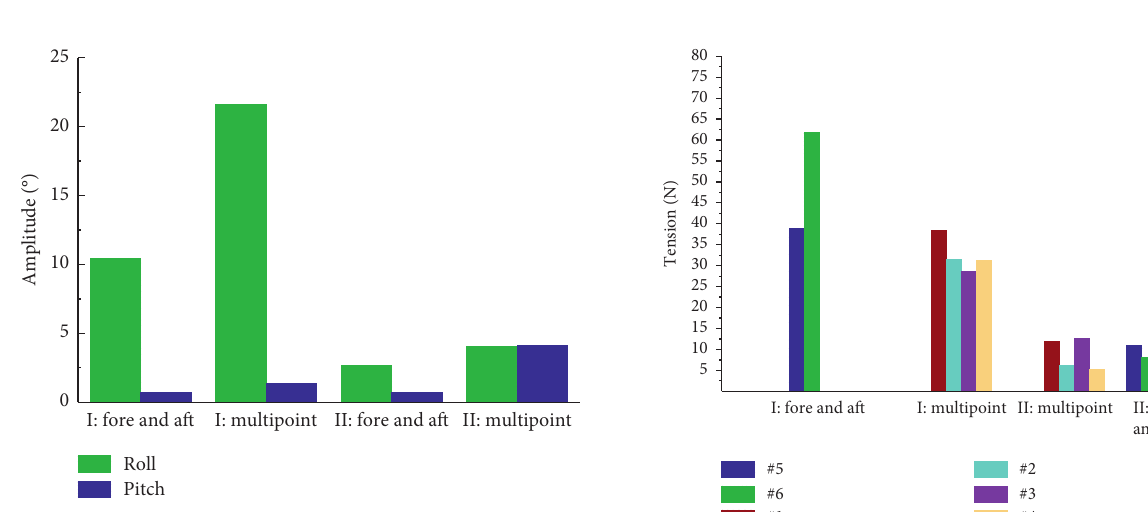
Figure 11: Comparative study of ship motion response charac- teristics under different operating conditions. Figure 12: Comparative study on tension characteristics of mooring cables under different working conditions.